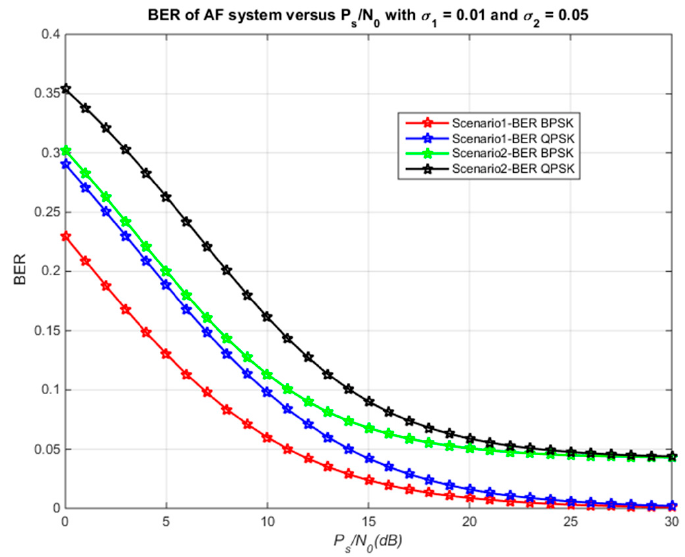
Figure 12. The optimal PS factor versus P s / N 0 for the second case.